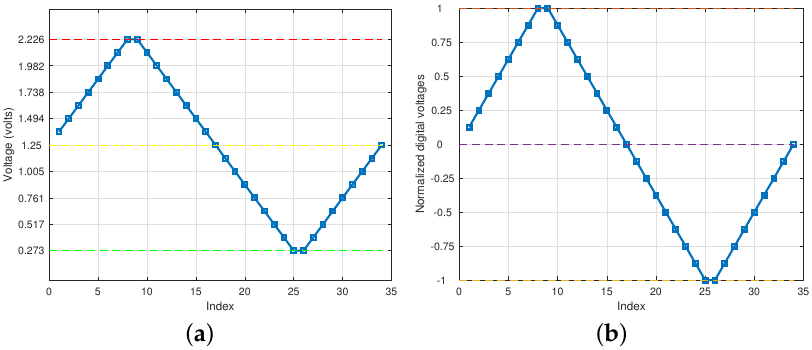
Figure 6. ( a ) Calibration voltages for DM constructing models in one period. ( b ) Normalized calibration voltages for DM constructing models in one period. Figure 7 displays the favorable fitting result of the first electrode for the x coordinate of the 111st spot. It indicates that a maximum modeling error of 0.05 pixels exists in the system which is kept under an acceptable threshold.